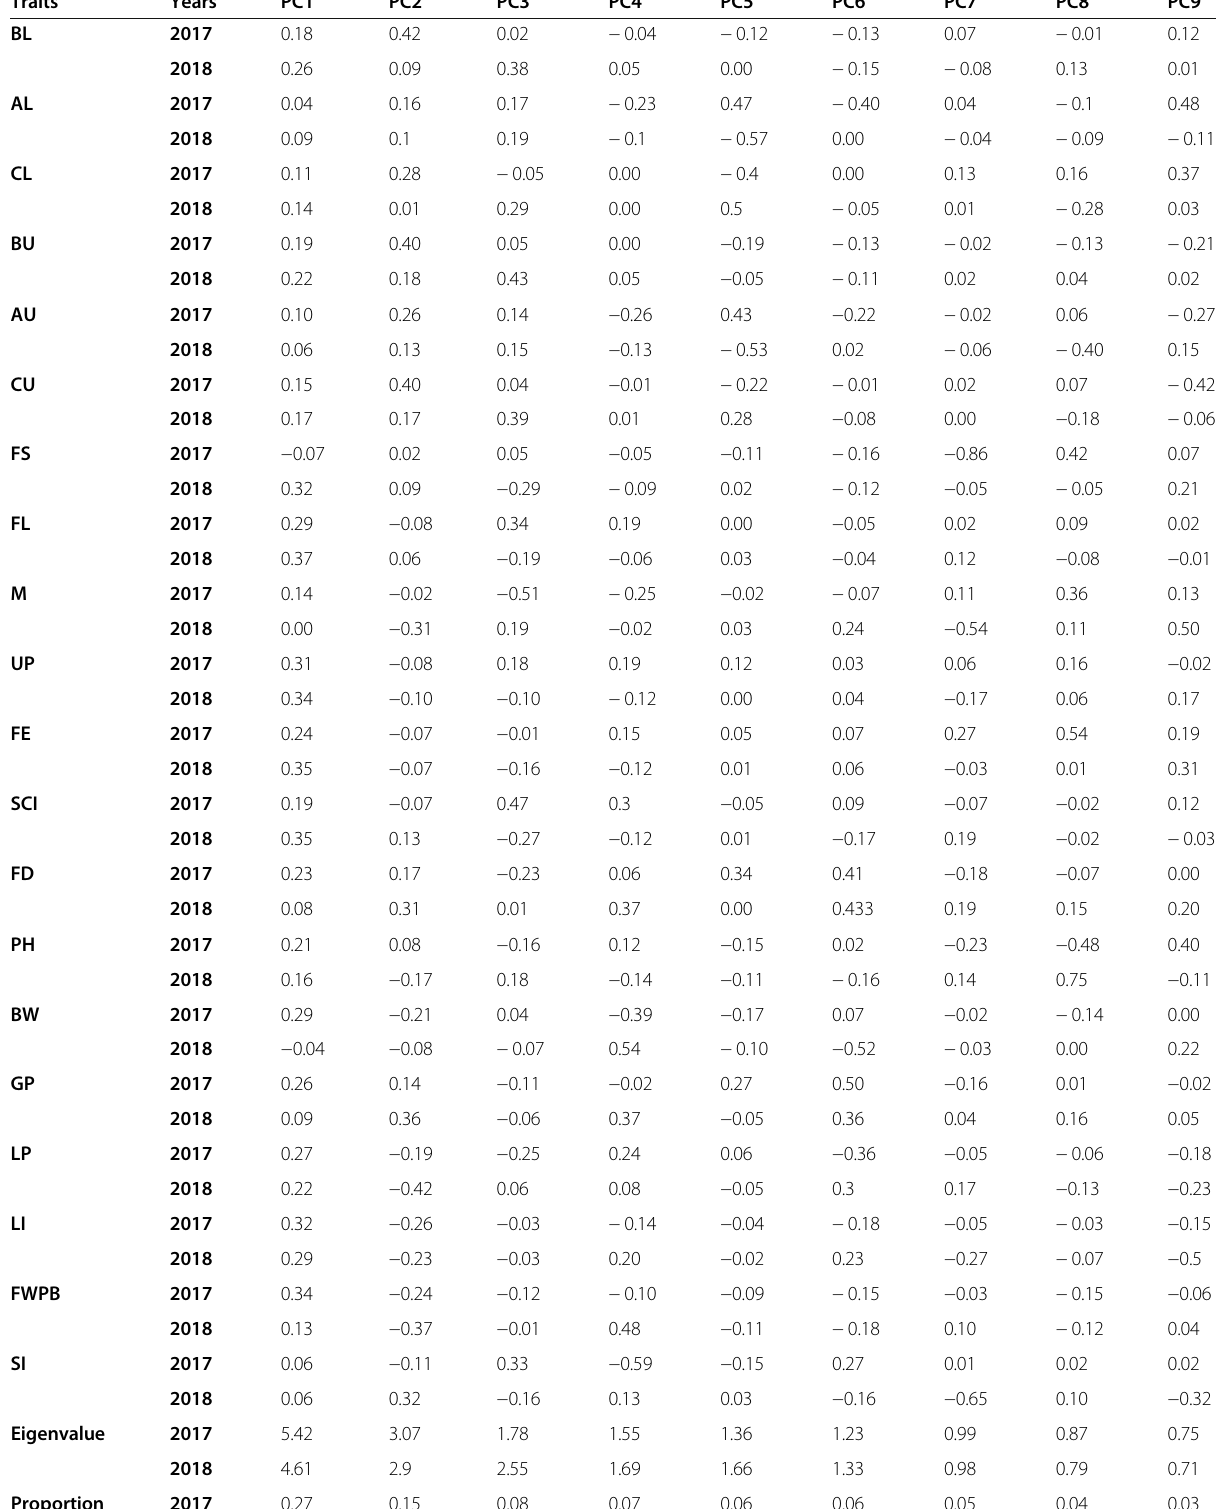
Table 2 Eigenvectors and eigen analysis of the correlation matrix for the nine principal components traits associated with stem hardness performance in G. hirsutum